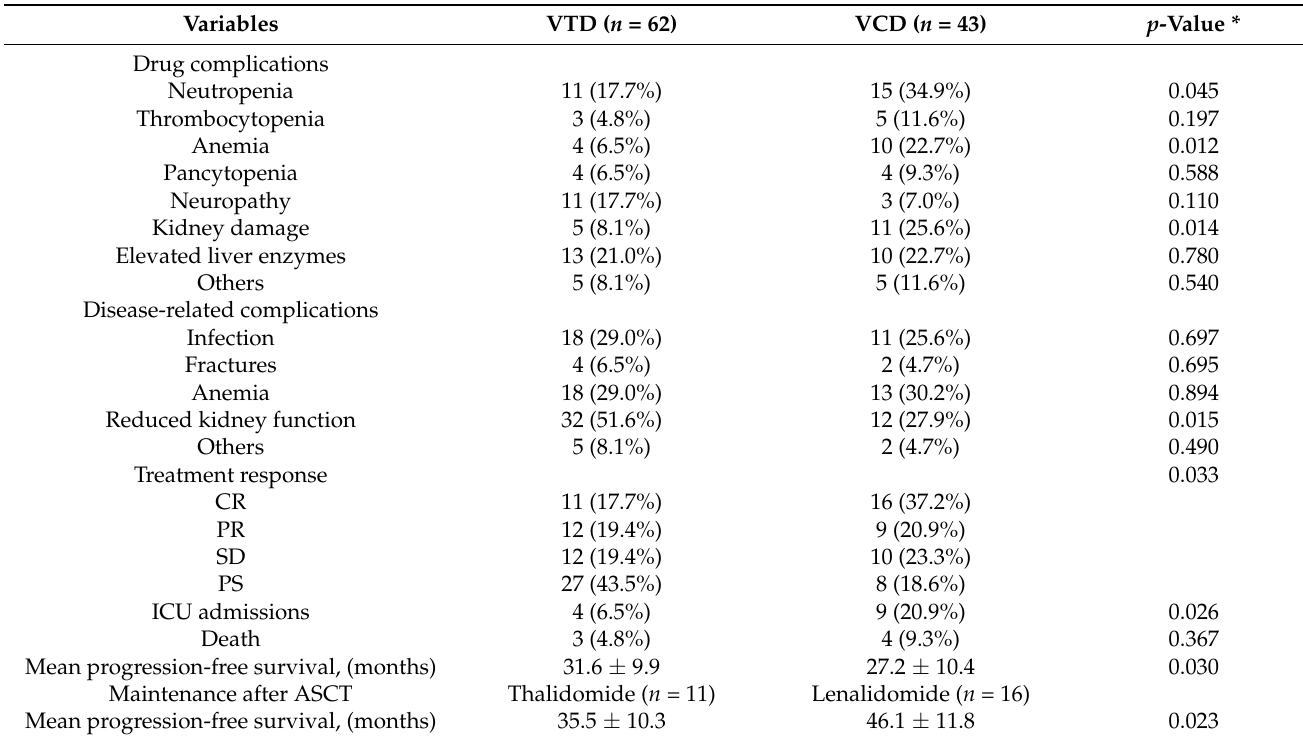
Table 4. Complications and outcomes during pretransplant therapy.